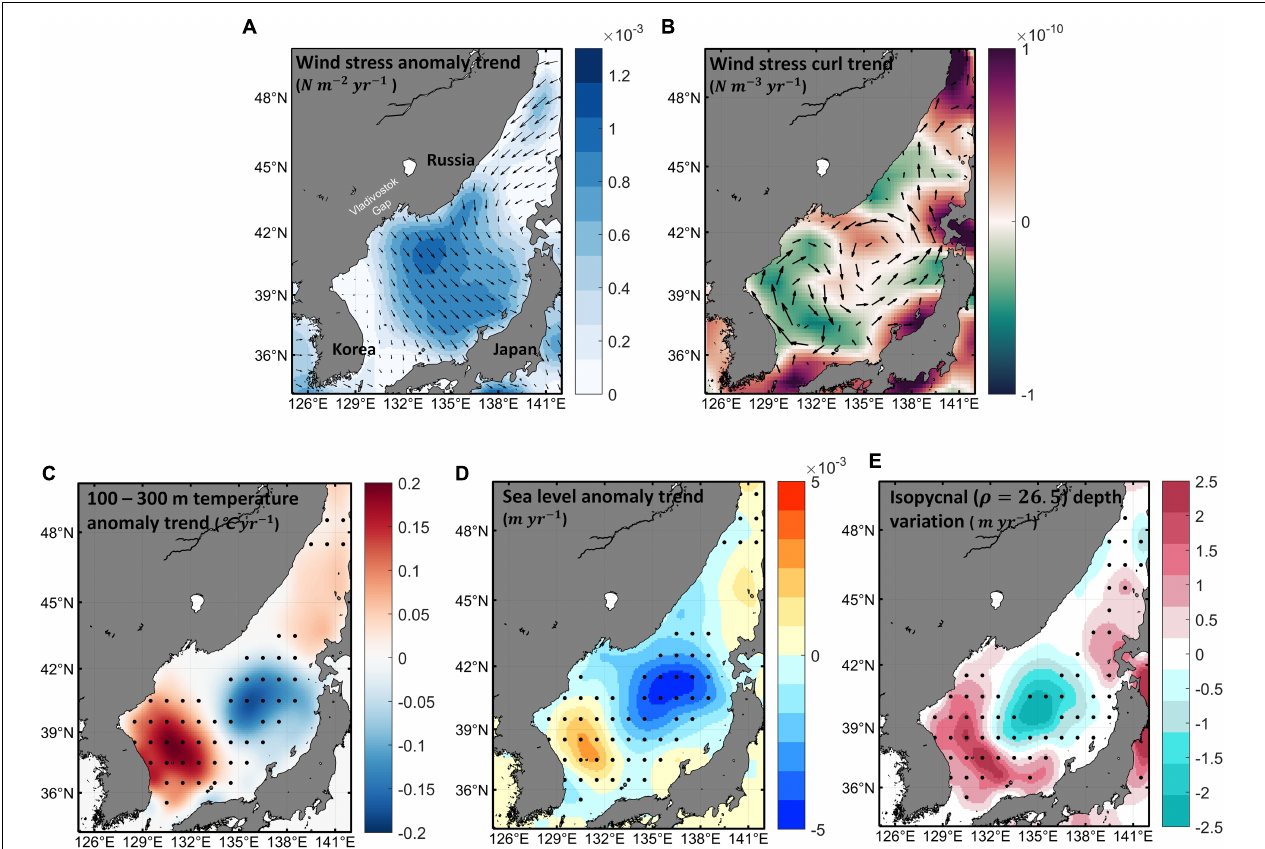
FIGURE 2 | Trend differences (SWS–SW) between the surface warming period (SW; 1985–1999) and surface warming slowdown period (SWS; 2000–2014). Long-term trends of (A) wind stress anomaly, (B) wind stress curl and current at the upper 300 m, (C) temperature anomaly at depths from 100 to 300 m, (D) SLA, and (E) isopycnals ( ρ = 2 6 . 5 ) during the SWS period. Positive value shown in panel (A) denotes strengthened wind stress, and the arrows point toward the direction of strengthening wind stress during the SWS period. Color scale in panel (B) shows the wind stress curl (positive cyclonic direction), and the black arrows